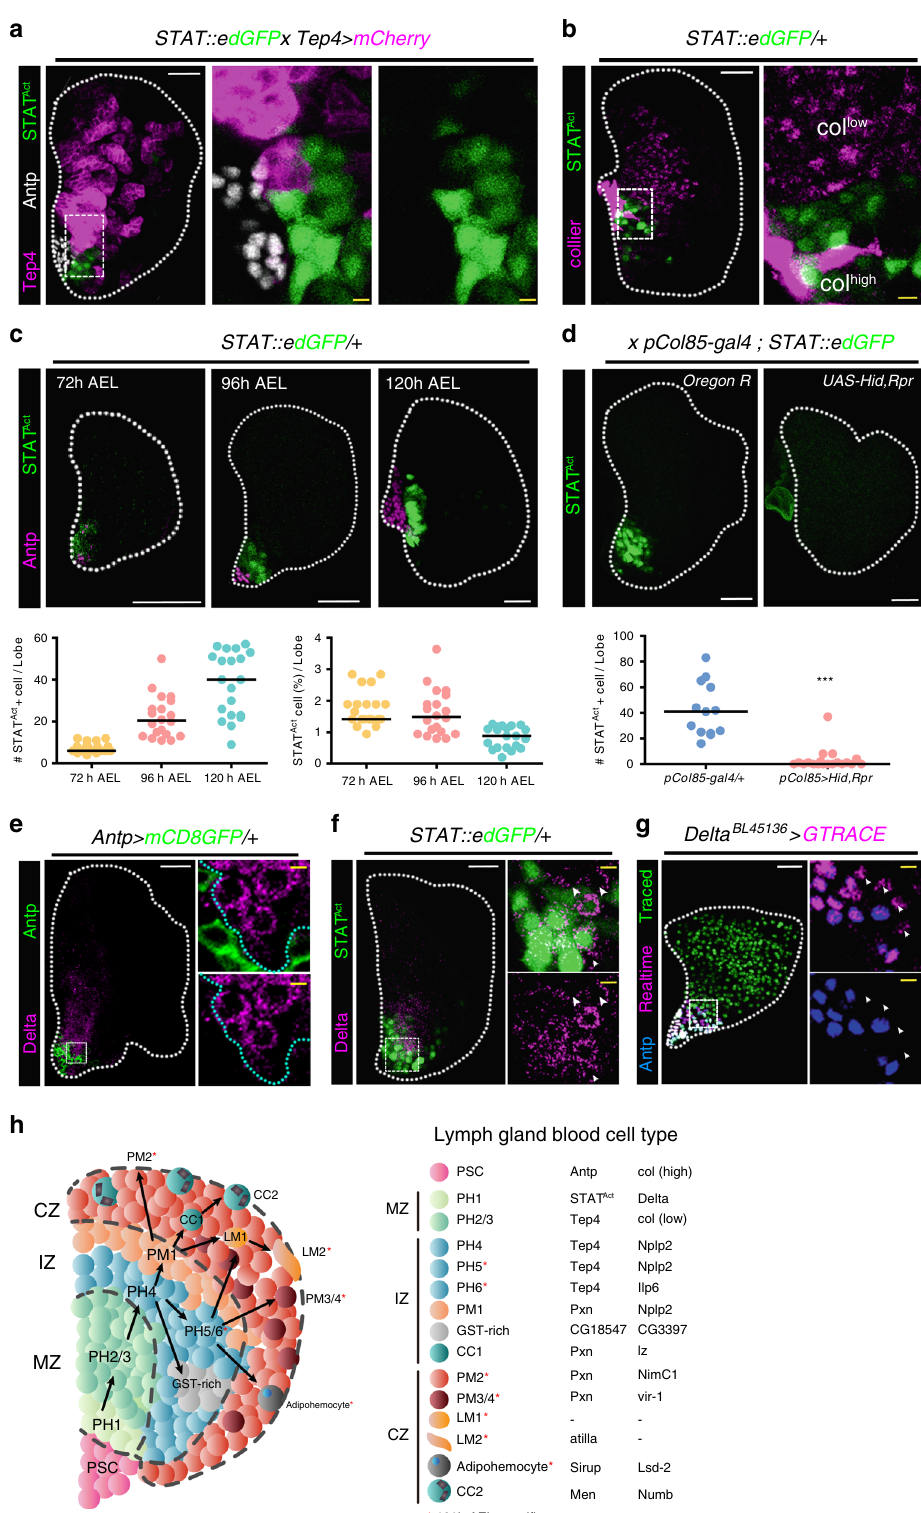
(Fig. 7b). We validated the data by tracing the intermediate zone or the cortical zone markers upon wasp infestation and con fi rmed that atilla + iLMs are derived from either Nplp2 + intermediate hemocytes or Hml + plasmatocytes (Fig. 7e). However, differ- entiating crystal cells and lamellocyte lineages are mutually